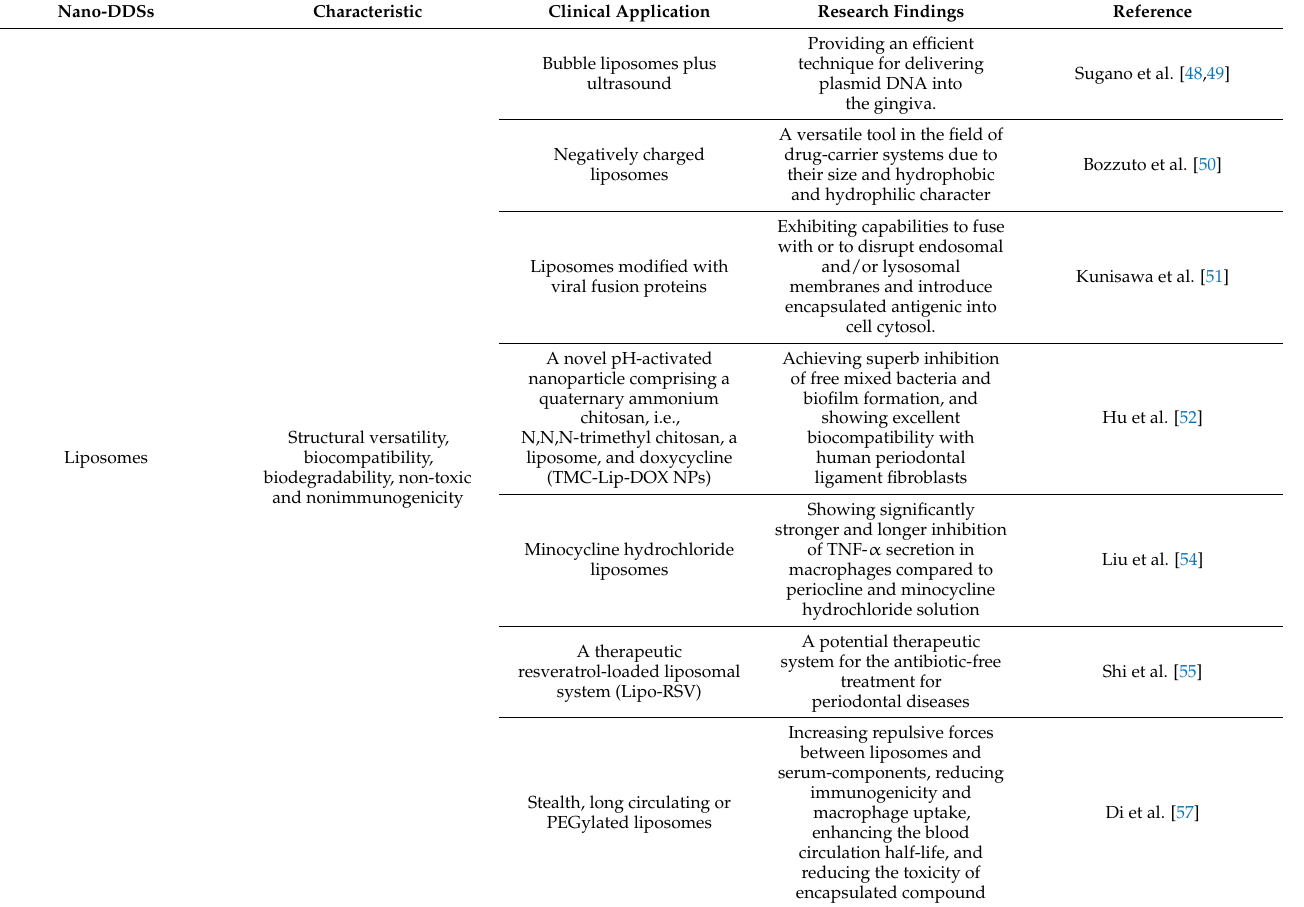
Table 2. Summary on Nanoparticulate Delivery Systems for Periodontal Tissue